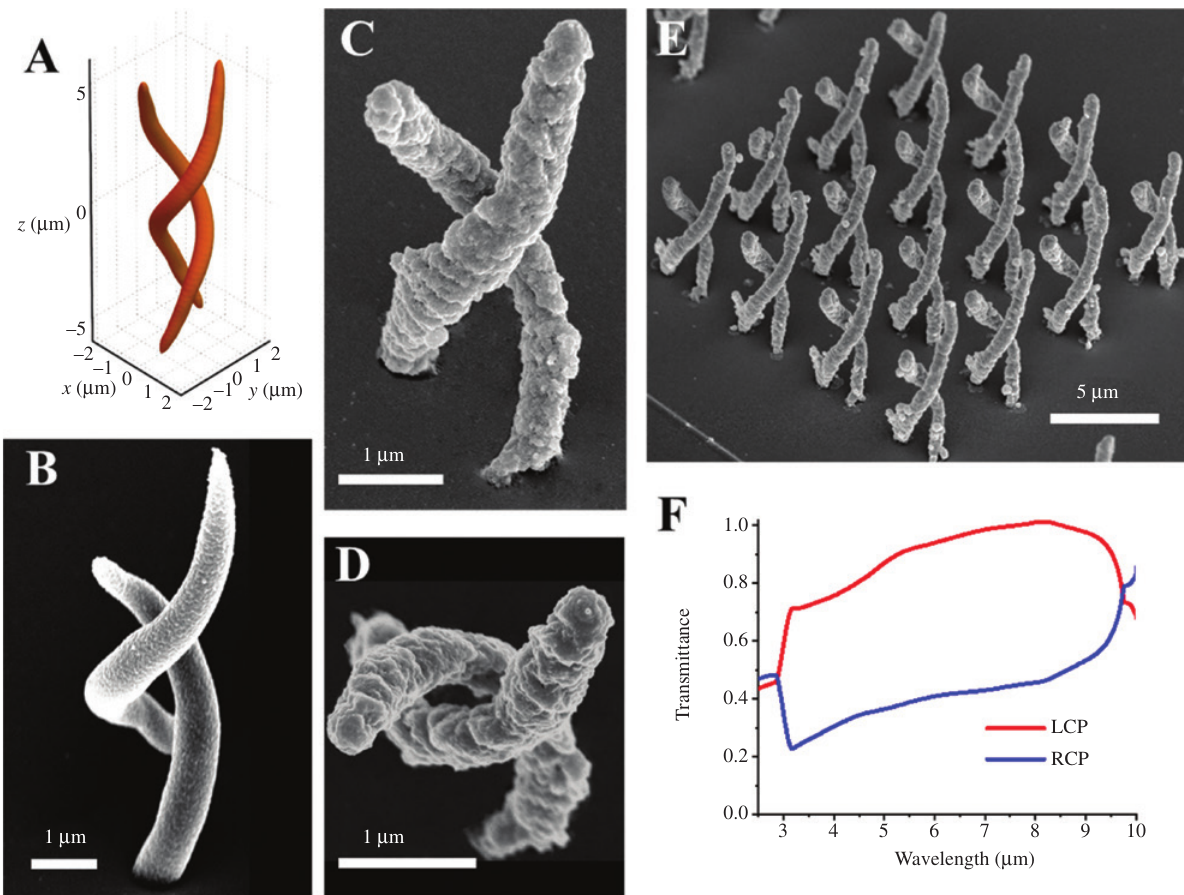
Figure 4: The photoreduction using the optimized double-helix focal field. (A) The optimized double-helix focal intensity distribution from the superposition of the LG modes with indices (1,1), (3,7), (5,13), (7,19) and (9,25). (B) The SEM images of a single, two-photon polymerized double helix. (C, D) The SEM images of a single photoreduced silver double helix. (E) The SEM image of a silver double-helix array. (F) The measured transmittance spectra of the silver double-helix array for LCP and RCP light at normal